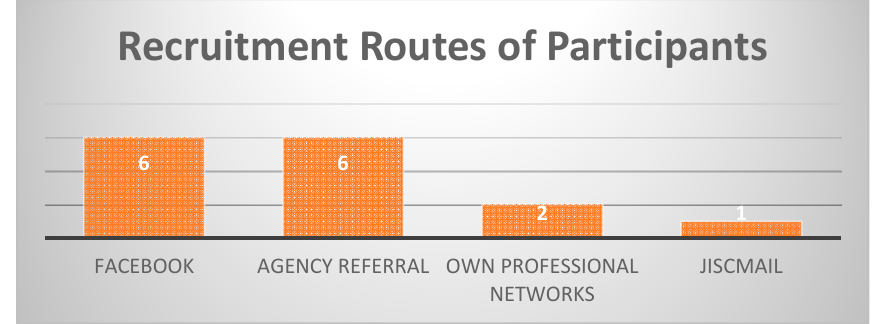
Figure 1. Recruitment routes of research participants.